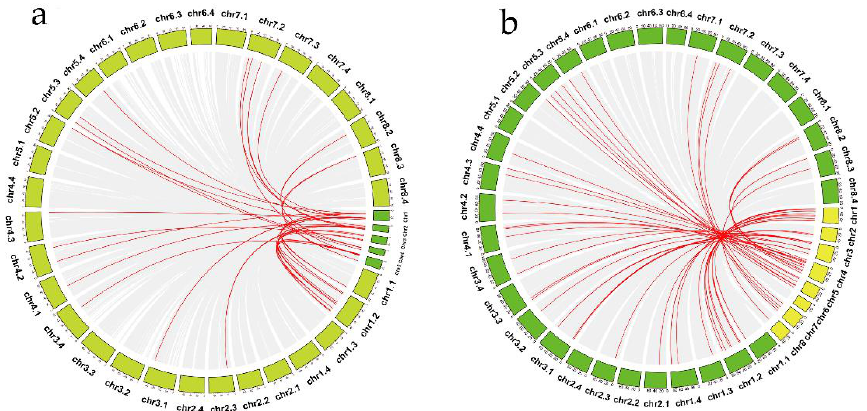
Figure 5. Synteny analysis of MsZFP genes with ( a ) Arabidopsis and ( b ) Medicago truncatula . The red line represents gene pairs that are homologous.